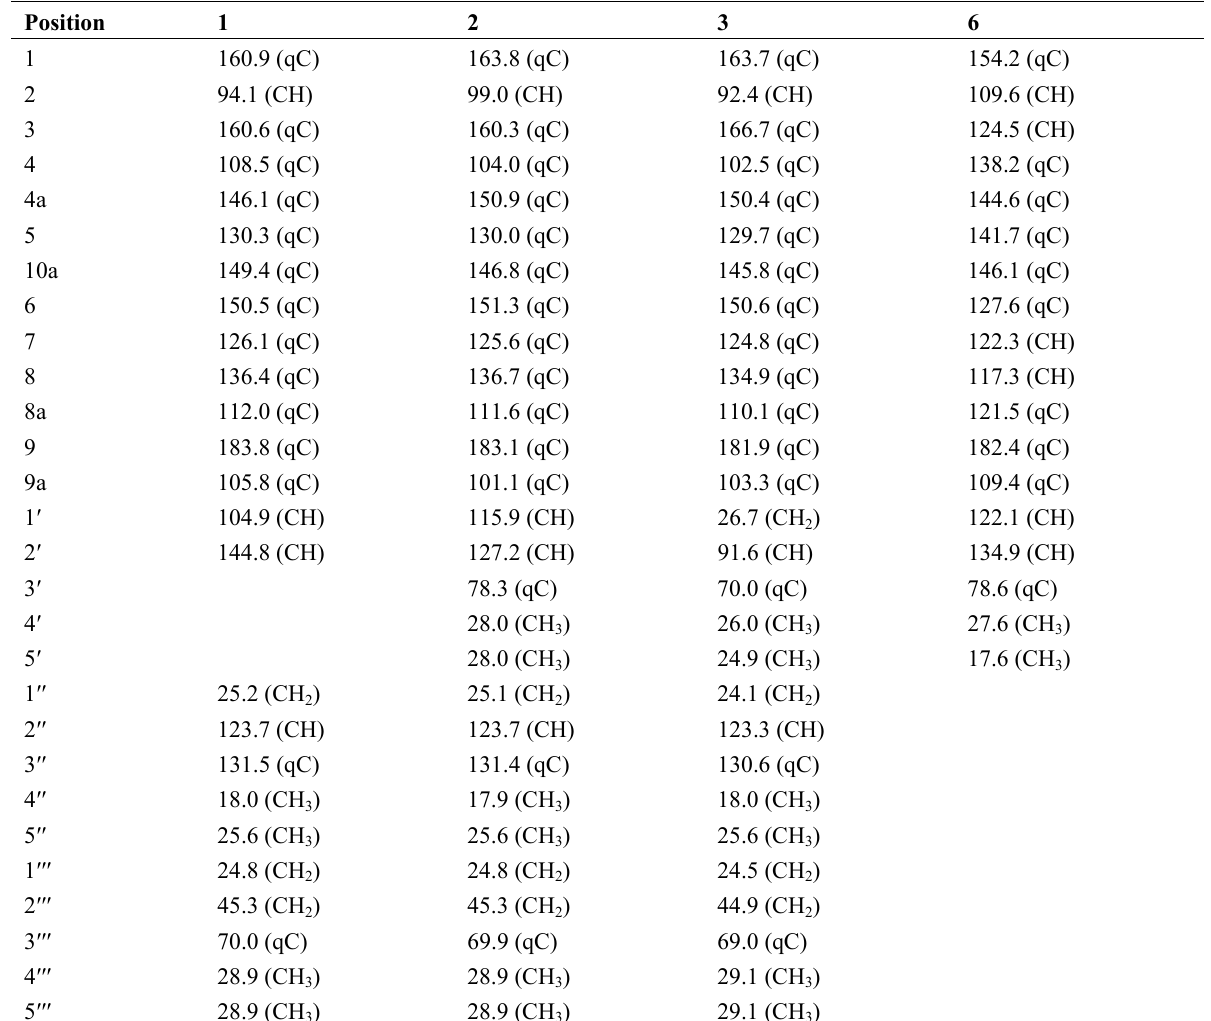
Table 2. 13 C-NMR data of compounds 1-3 and 6 .